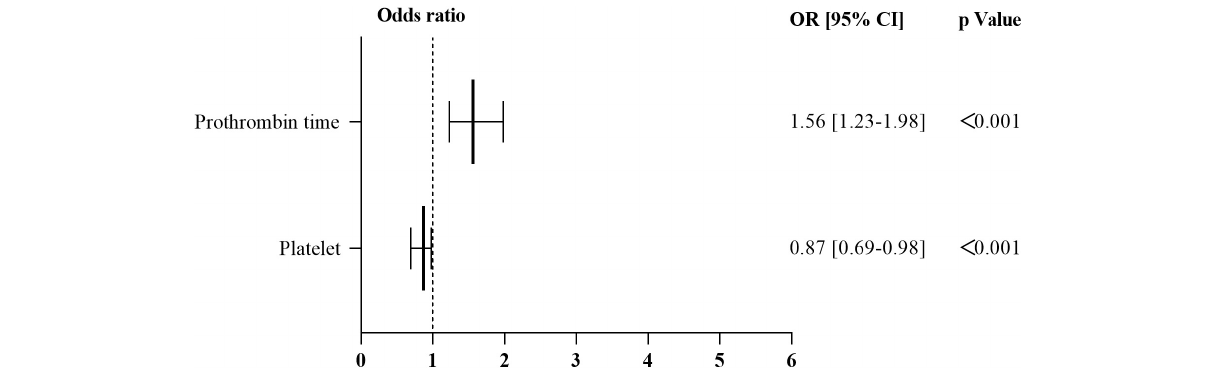
and specificity of 89.3% ( Figure 8 and Supplementary Appendix Table 9 ).